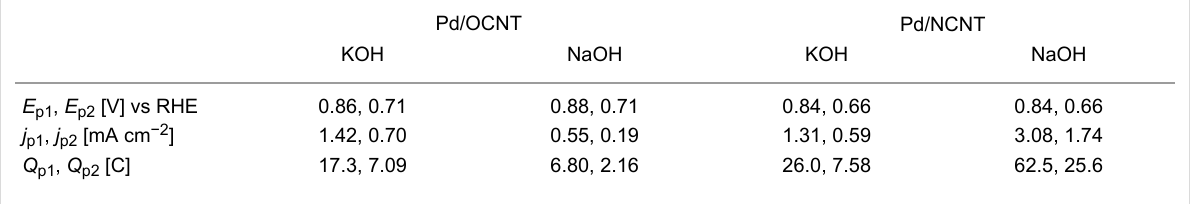
Table 1: Peak potentials E p1 and E p2 , peak current densities j p1 and j p2 , and peak charges Q p1 and Q p2 extracted from the CVs shown in Figure 1 and Figure 2.